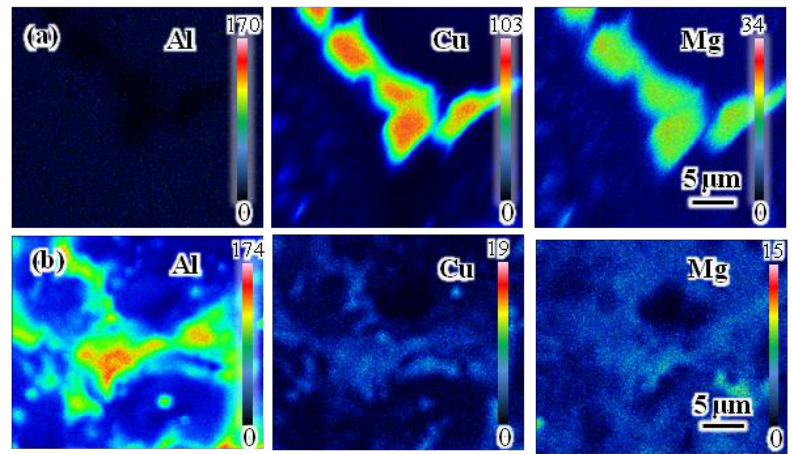
Figure 3. ( a ) Original element distribution of Al-Cu-Mg alloys by electron microprobe analysis (EPMA); ( b ) element distribution of Al-Cu-Mg alloys after PED treatment.